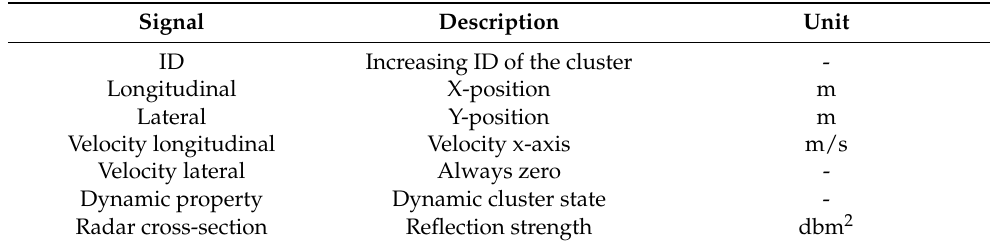
Table 2. Basic information of a single cluster, of the radar sensor Continental